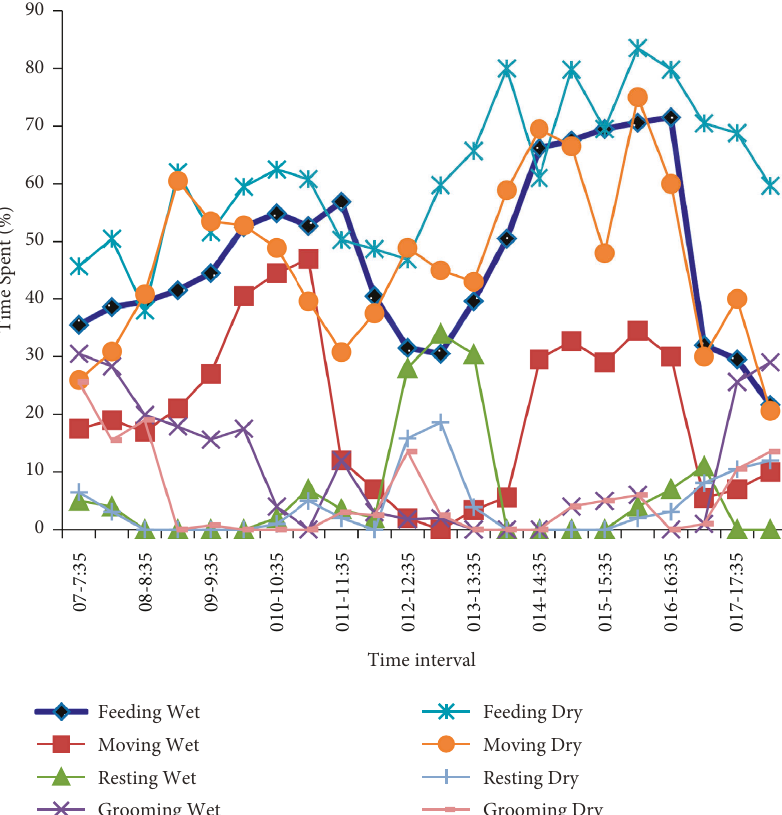
Figure 2: Dominant behaviors diurnal activity pattern of geladas during the wet and dry season in Kotu forest,